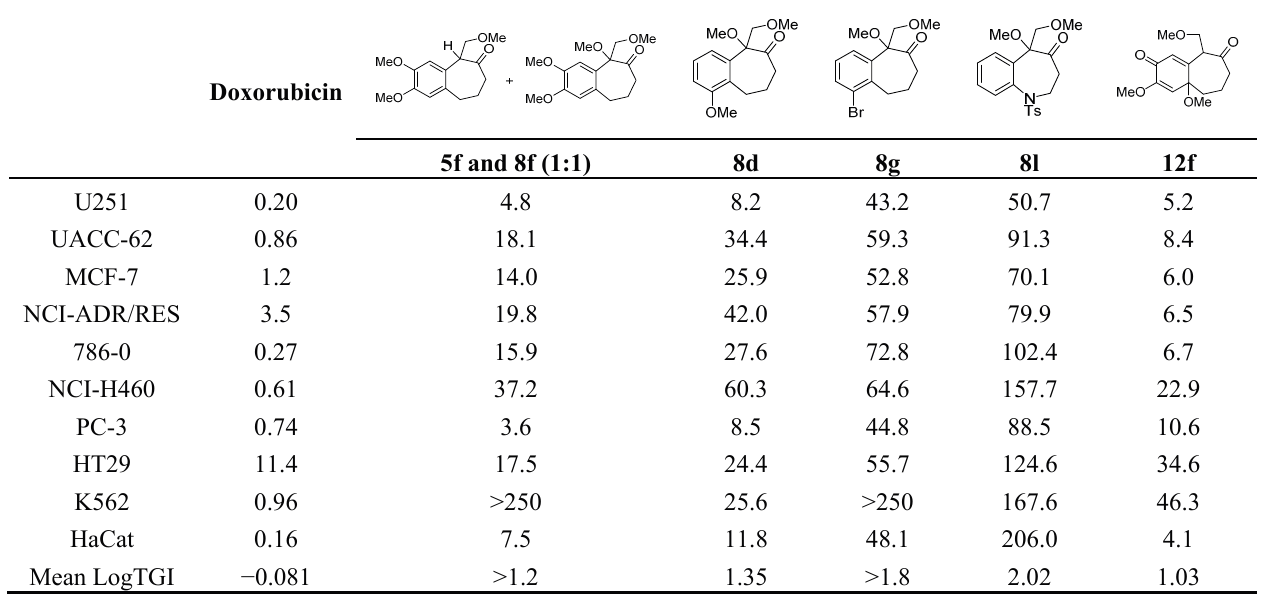
Table 3. Antiproliferative activities (TGI, µg·mL − 1 ) of ring expansion products a .